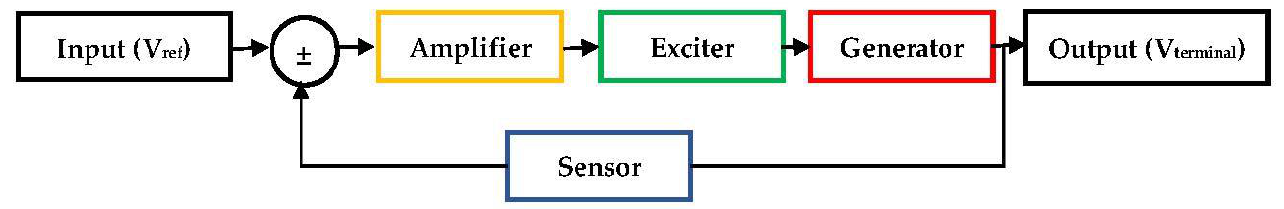
Figure 1. Block diagram of an AVR system.